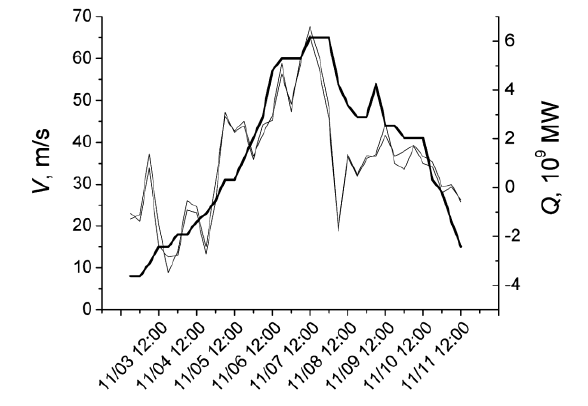
Figure 10. The TC Haiyan evolution